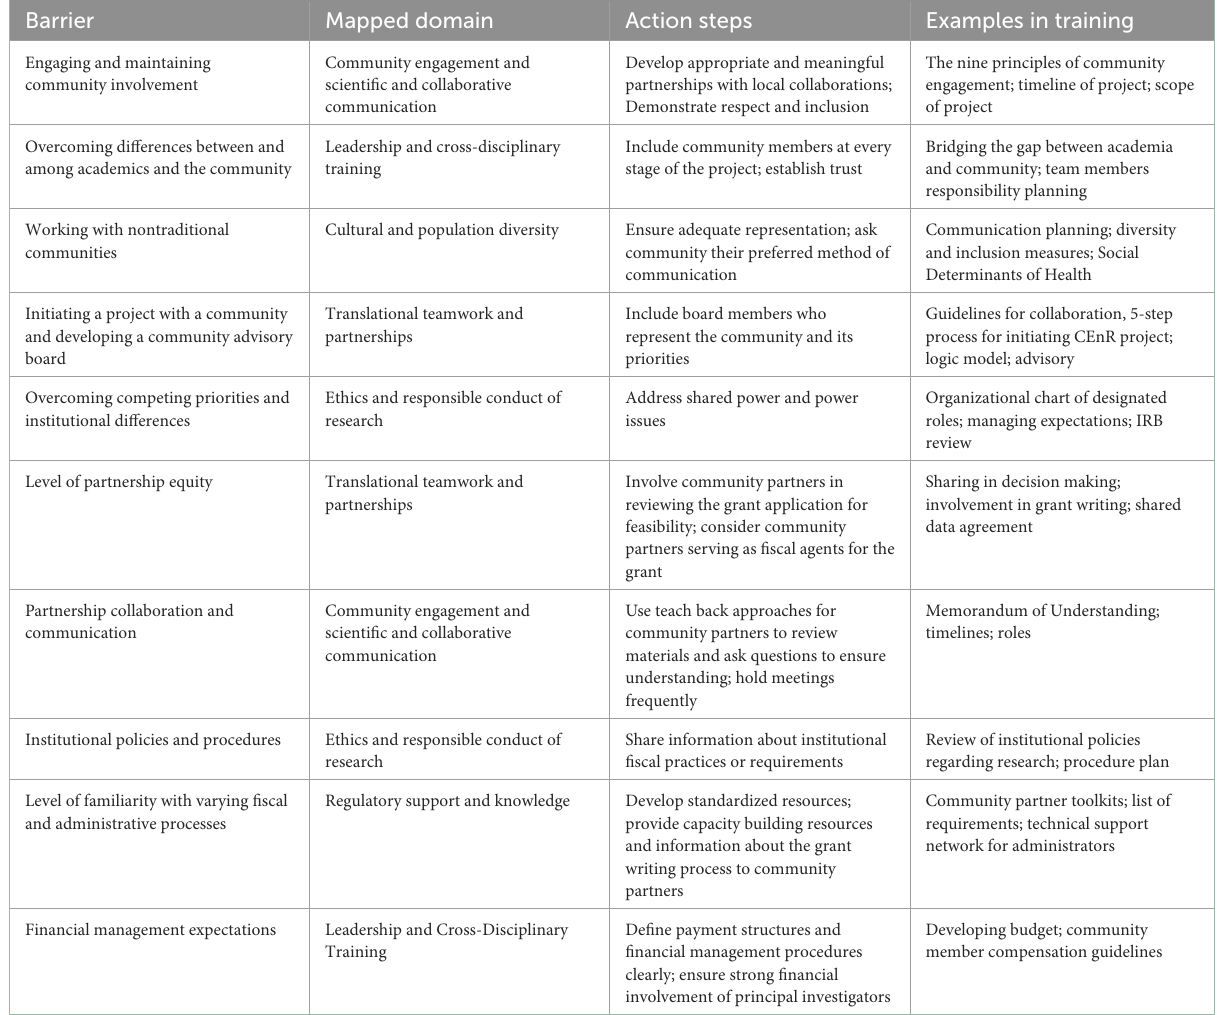
TABLE 2 Addressing institutional and community barriers to achieve effective